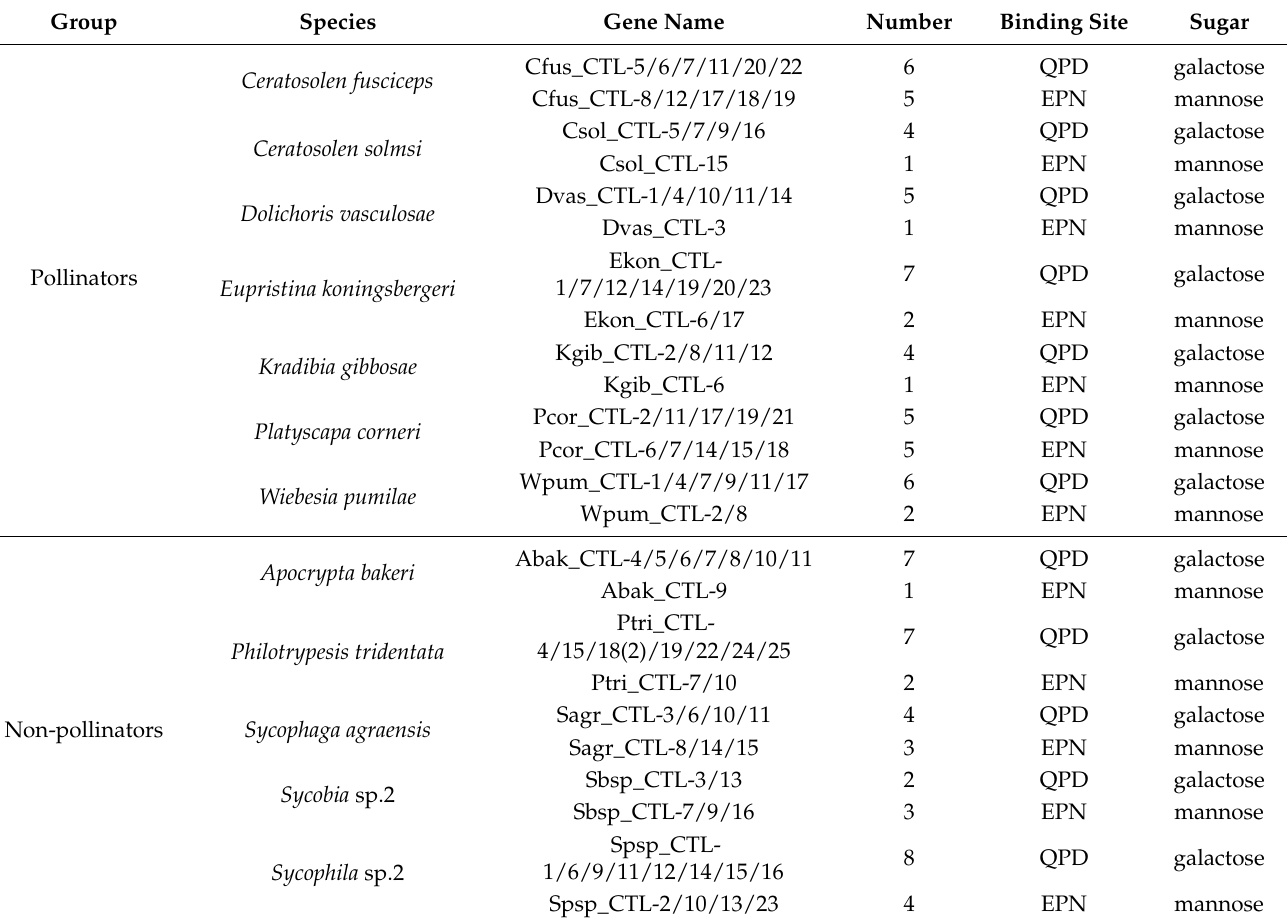
Table 2. Statistical analysis of CTL genes for specific recognition of sugars in fig wasps.